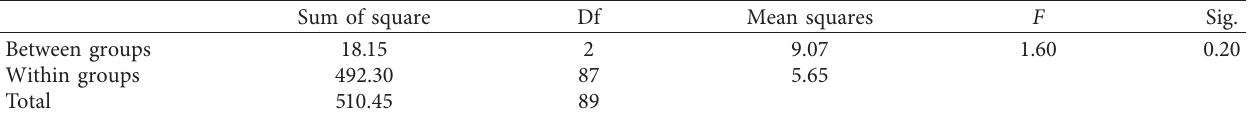
Table 2: One-way ANOVA (pretest of vocabulary).